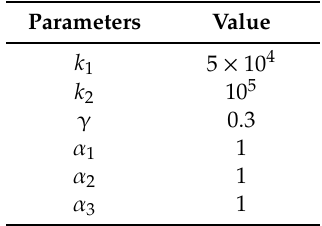
Table 2. Parameters of RCSMC.